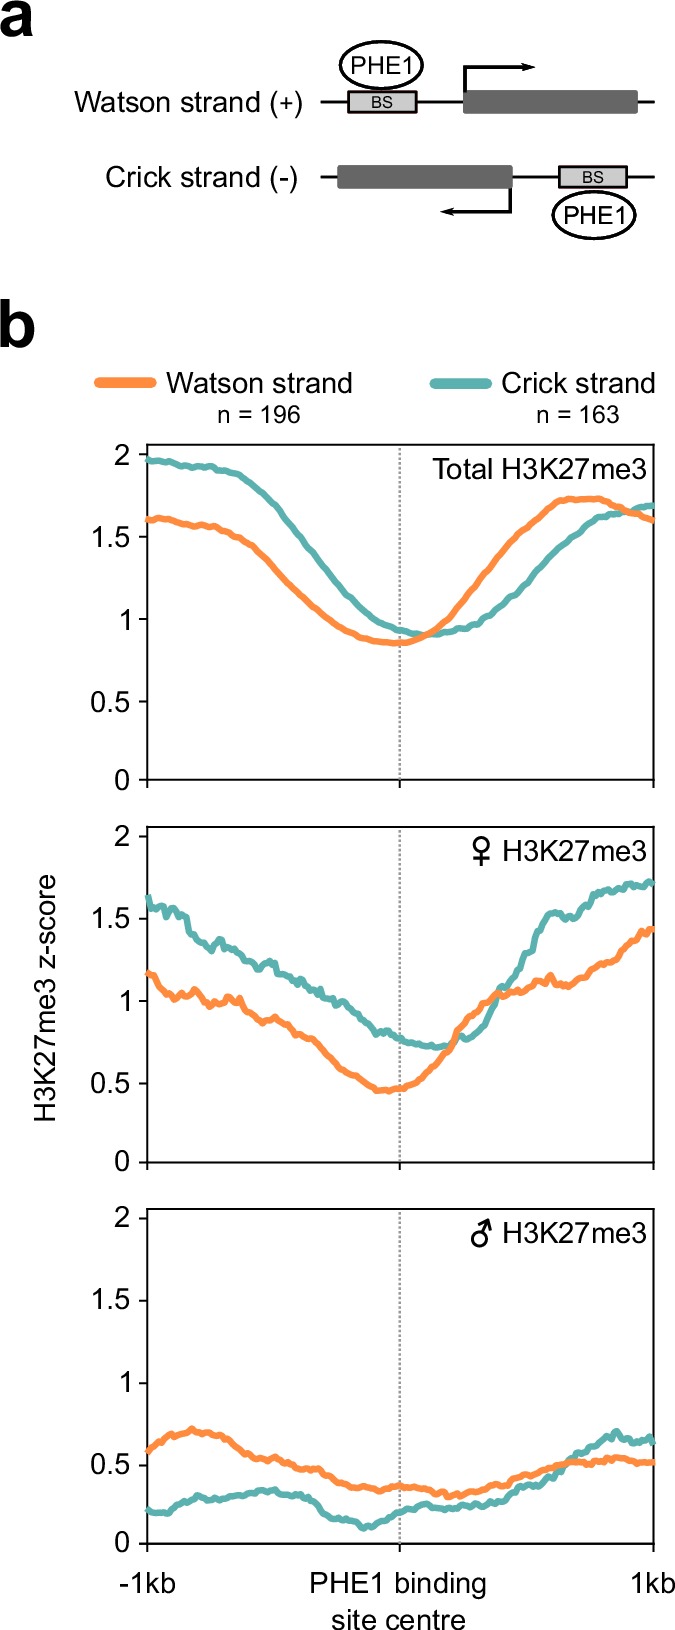
Directionality of H3K27me3 distribution in Cluster 1 binding sites.(a) Binding sites and their respective target genes can be present in the Watson (+) or Crick (–) strand of DNA. (b) Metagene plots of H3K27me3 distribution in PHE1binding sites associated with target genes located in the Watson (orange line) or Crick strands (blue lines). For this analysis, only H3K27me3 distributions in PHE1-binding sites associated with Cluster 1 were considered (Figure 4b). Total, maternal, and paternal H3K27me3 is represented in the top, middle, and bottom panels, respectively.